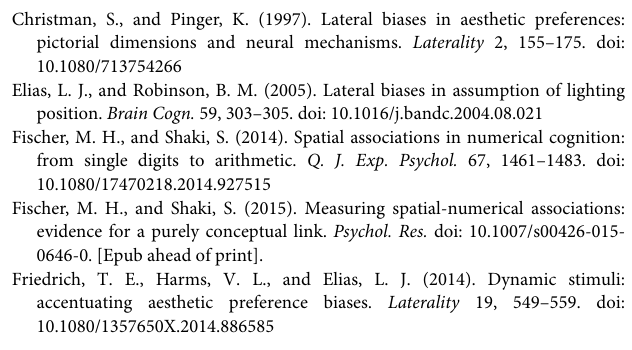
numerosity varied. However, this means that numerosity co- varied either with density (in the first condition) or with area (in the second condition). Therefore, chicks in all control conditions responded to both numerosity and at least one uncontrolled dimension, as they were in the first and second experiments, too. This methodological detail contains the core of our concern because both density and area are indeed spatially effective